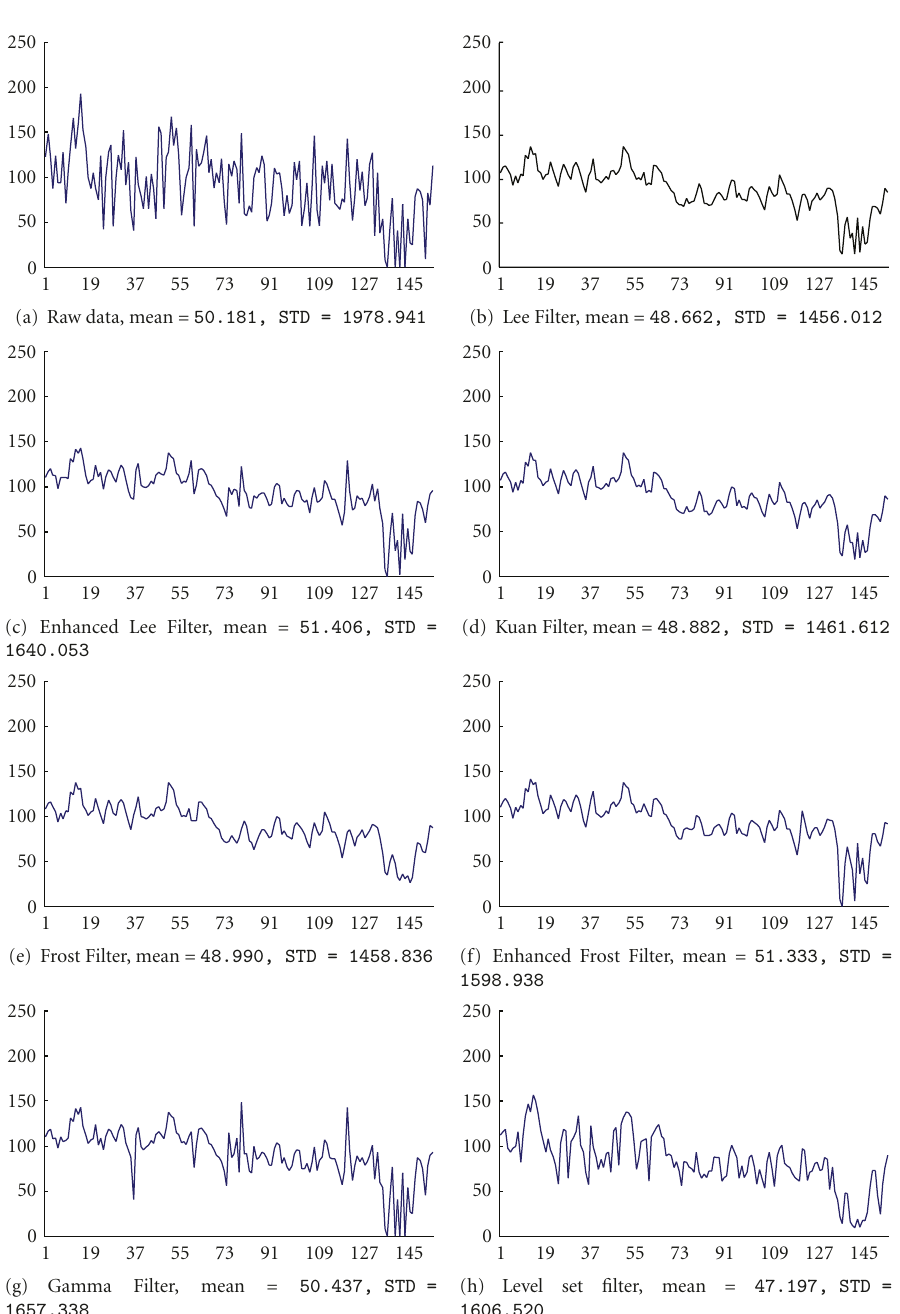
Figure 7: The profiles of Region E resulted from the proposed level set-based filter and conventional